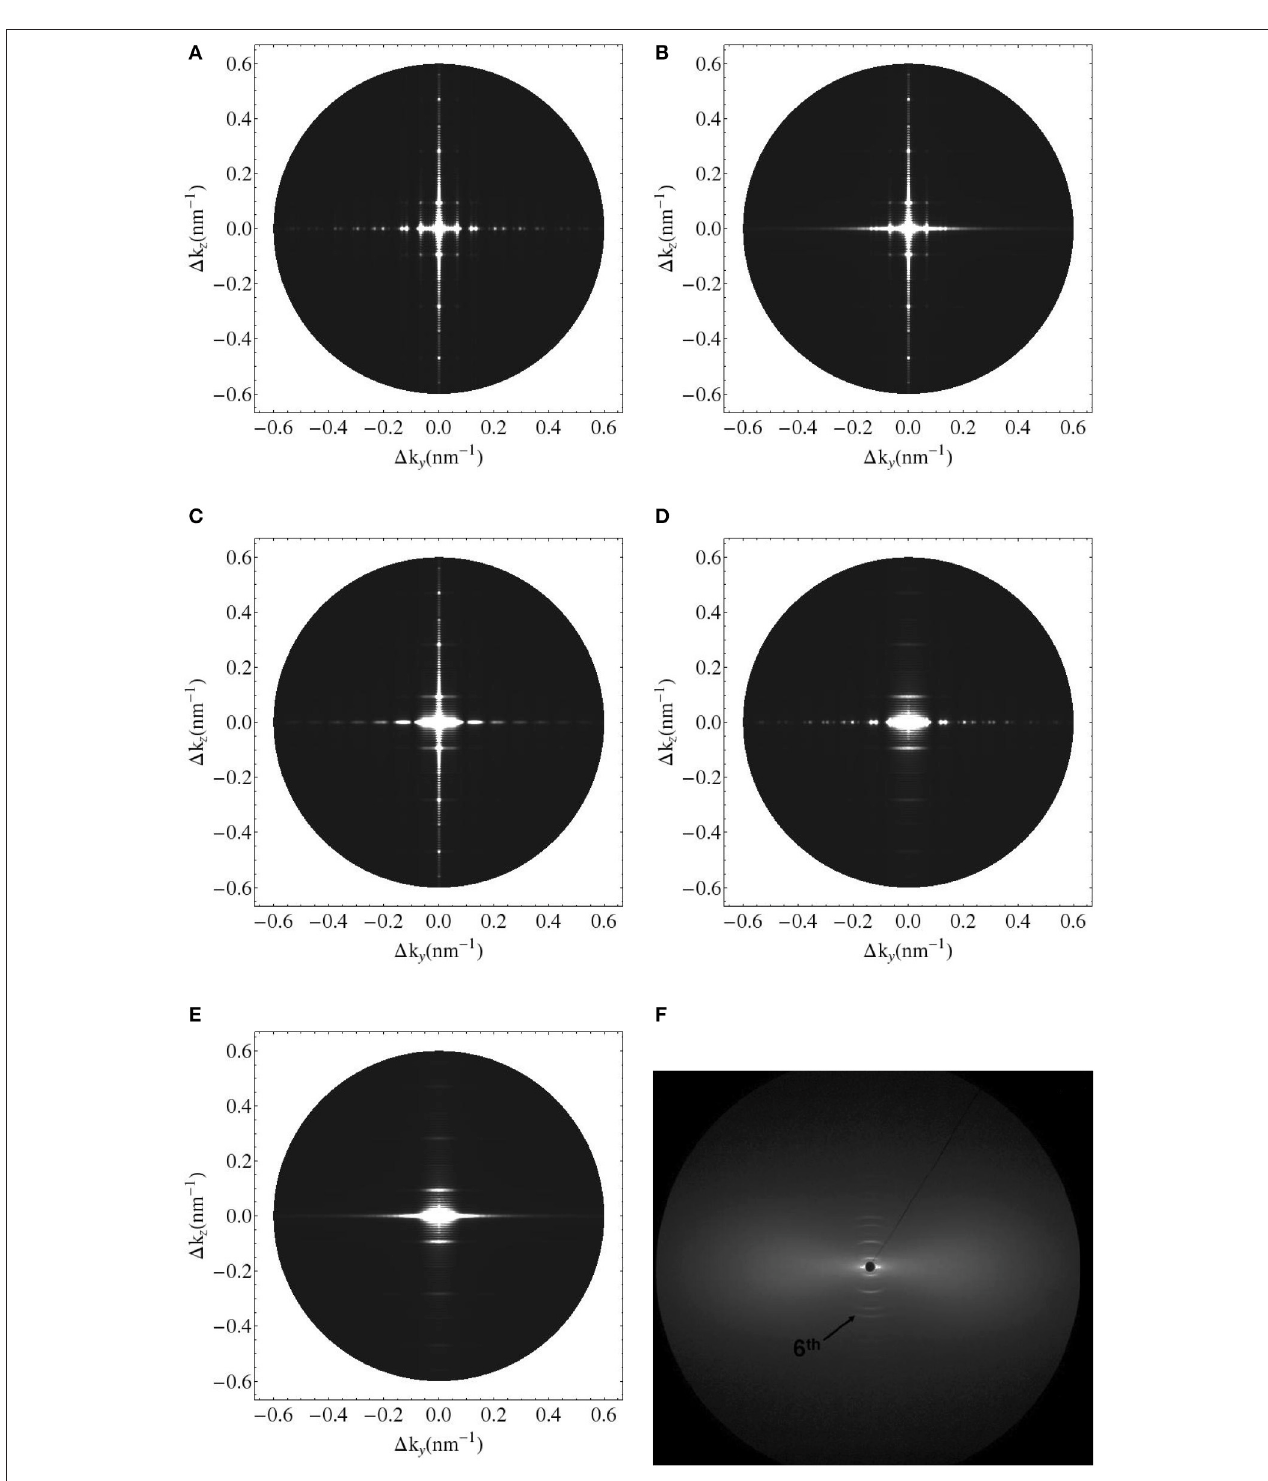
FIGURE 8 | Simulated 2D X-ray diffraction patterns with perfect axial and hexagonal order (A) , with perfect order and variable fibril diameter (B) , with constant fibril diameter, perfect axial order but lattice disorder (C) , with constant fibril diameter, perfect lattice order but axial disorder (D) , with lattice and substitutional disorder and variable fibril diameter (E) , and experimental pattern for shad fish bone (F) [95].